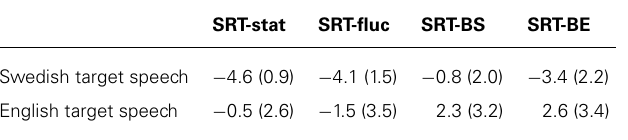
Table 1 | Means and SDs (between parentheses) of the SRTs in Swedish and